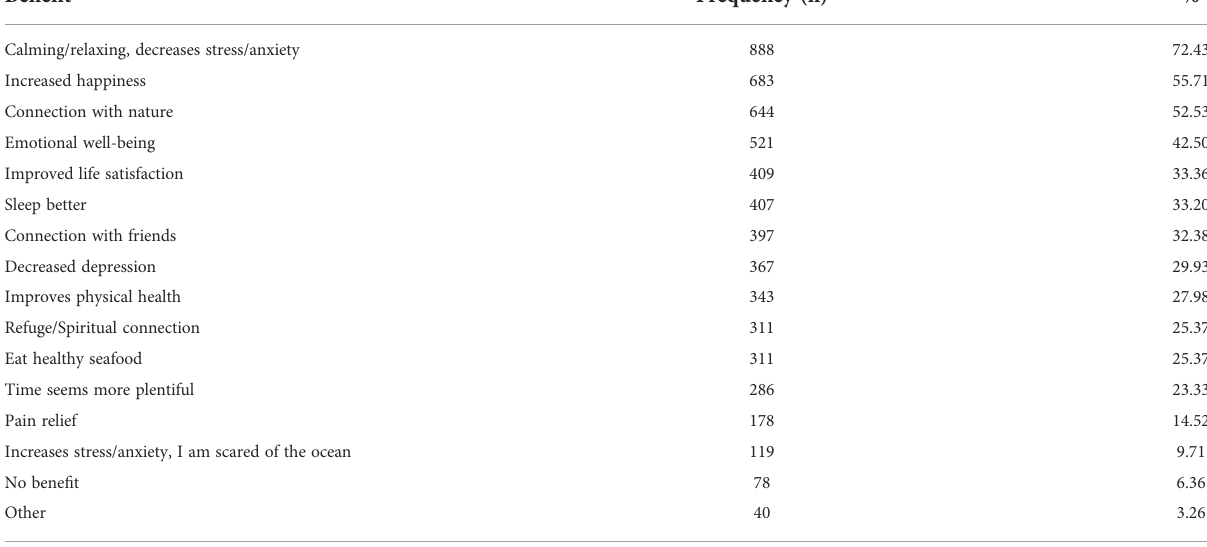
TABLE 4 Self-perceived bene fi ts of the ocean on participants ’ well-being and health (N = 1226). Bene fi t